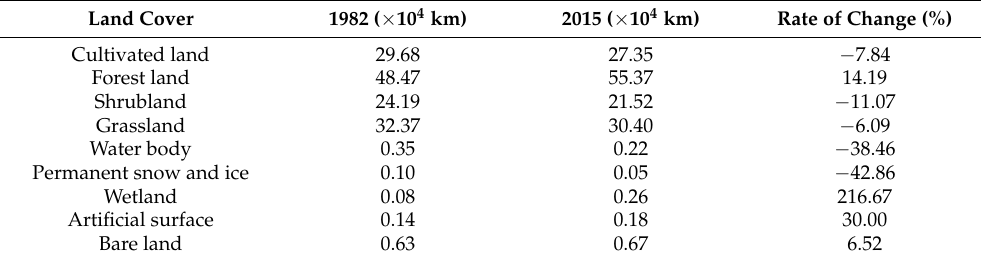
Figure 4. Comparison of the land cover and spatial pattern of NDVI in 1982 ( a ) and 2015 ( b ). Table 1. Changes of land cover between 1982 and 2015.